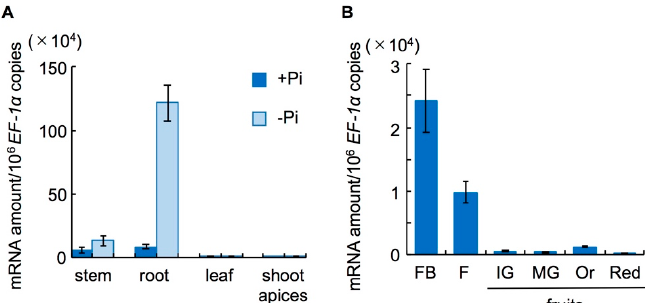
Figure 1. Quantitative real-time PCR (qRT-PCR) analysis of SlCCD8 expression in wild-type (WT) Micro-Tom tomato. ( A ) Twenty-day-old seedlings. ( B ) Mature 120-day-old plants. FB, flower bud; F, flower; IG, immature green fruits; MG, mature green fruits; Or, orange fruits; Red, red fruits. Error bars, Standard error (S.E.) ( n =